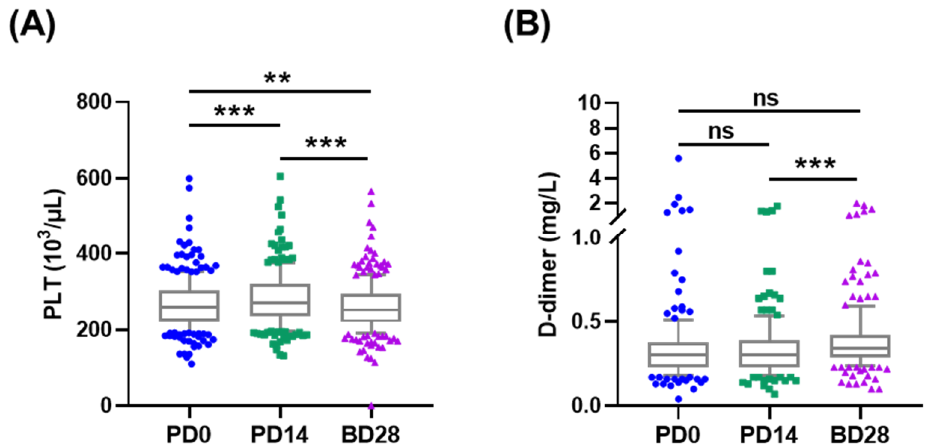
Figure 3. Platelet counts and D-dimer responses induced by vaccination. ( A ) Platelet counts and ( B ) ( B ) D-dimer levels were tested at PD0, PD14, and BD28. ** p < 0.01; *** p < D-dimer levels were tested at PD0, PD14, and BD28. ** p < 0.01; *** p < 0.001.